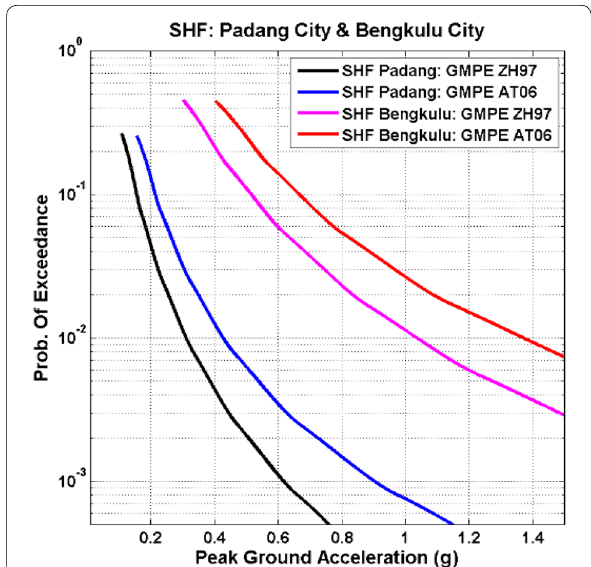
Fig. 5 Comparison of the Seismic Hazard Function (SHF) at the base rock of the nearby coastal cities of Padang and Bengkulu. The results show that the SHF of Bengkulu is higher than that of